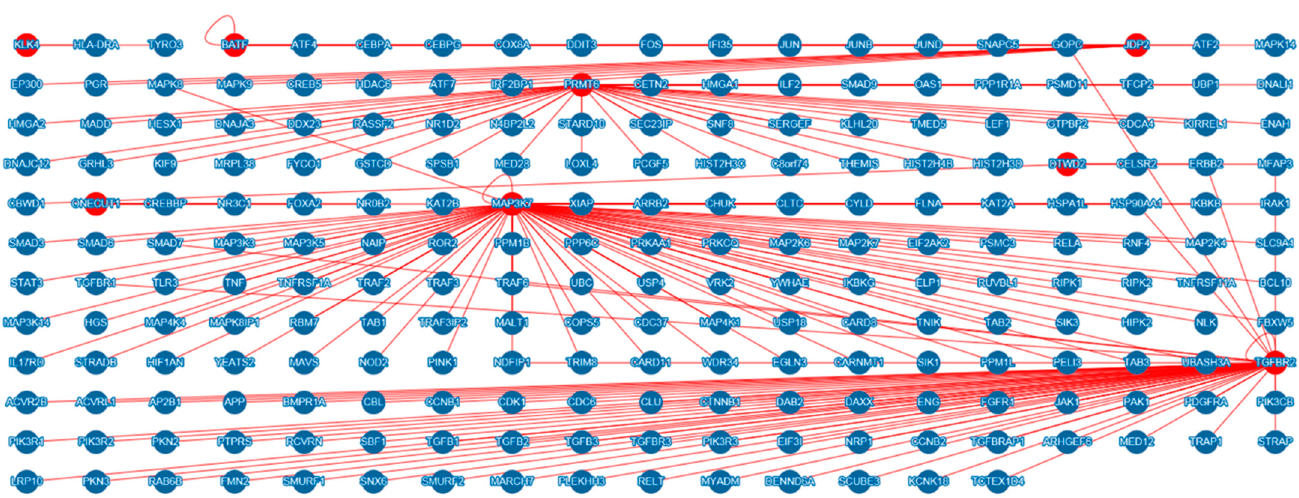
Figure 4. Protein-protein interaction genes with candidate genes of scrub typhus. Protein-protein interaction genes with candidate genes of scrub typhus were analyzed by MIST v5.0 (http://fgrtools.hms.harvard.edu/MIST/) using grid layout. Red circles indicate candidate genes of scrub typhus. Red lines indicate protein-protein interactions. Table 3. Immune-related genes that interact with candidate genes of scrub typhus based on protein-protein interaction.